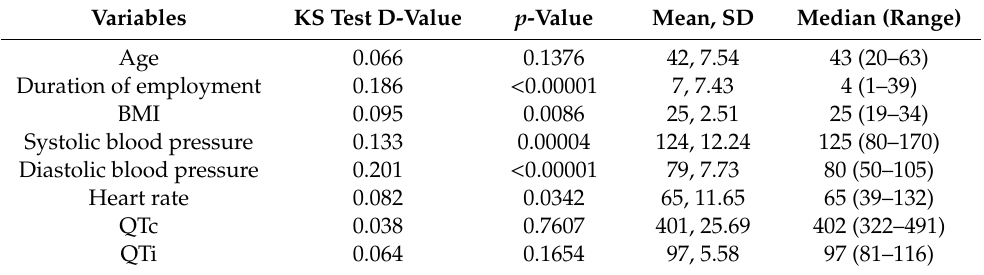
Table 1. Test for the assumption of normality of the distribution of the continuous variables presented in Table 2 of Lecca et al. (1). BMI—body mass index; KS—Kolmogorov–Smirnov; SD—standard